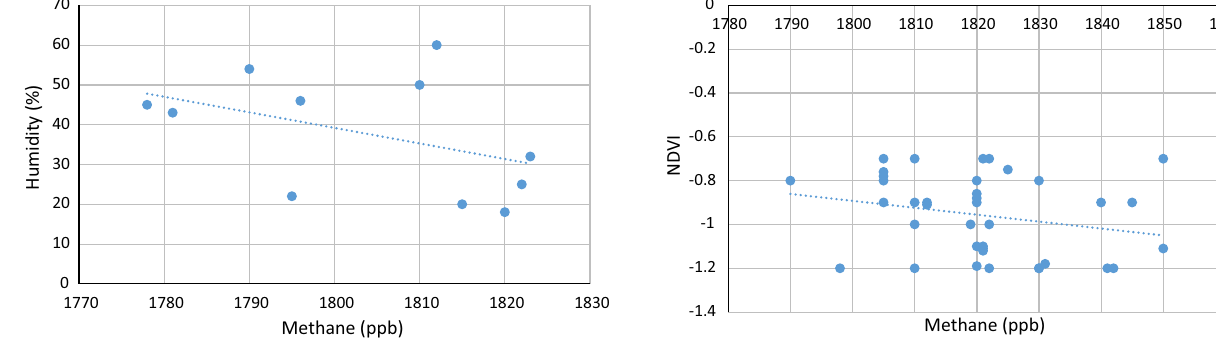
Fig. 4 Relationship between monthly methane and humidity in 2018